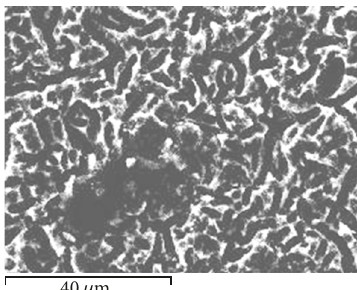
Figure 5: SE image of the right breakdown site in Figure 2(b).